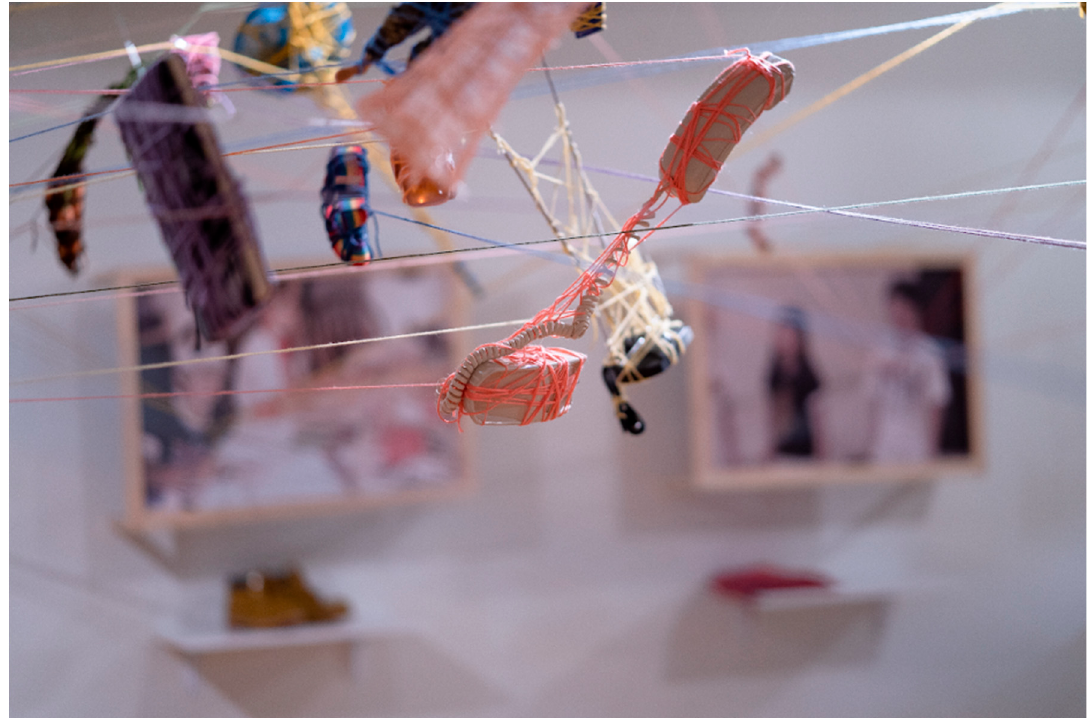
Figure 8. Detail photo of a phone entangled in Becoming Us , 2018 (Photo graciously provided by Megan Altieri).